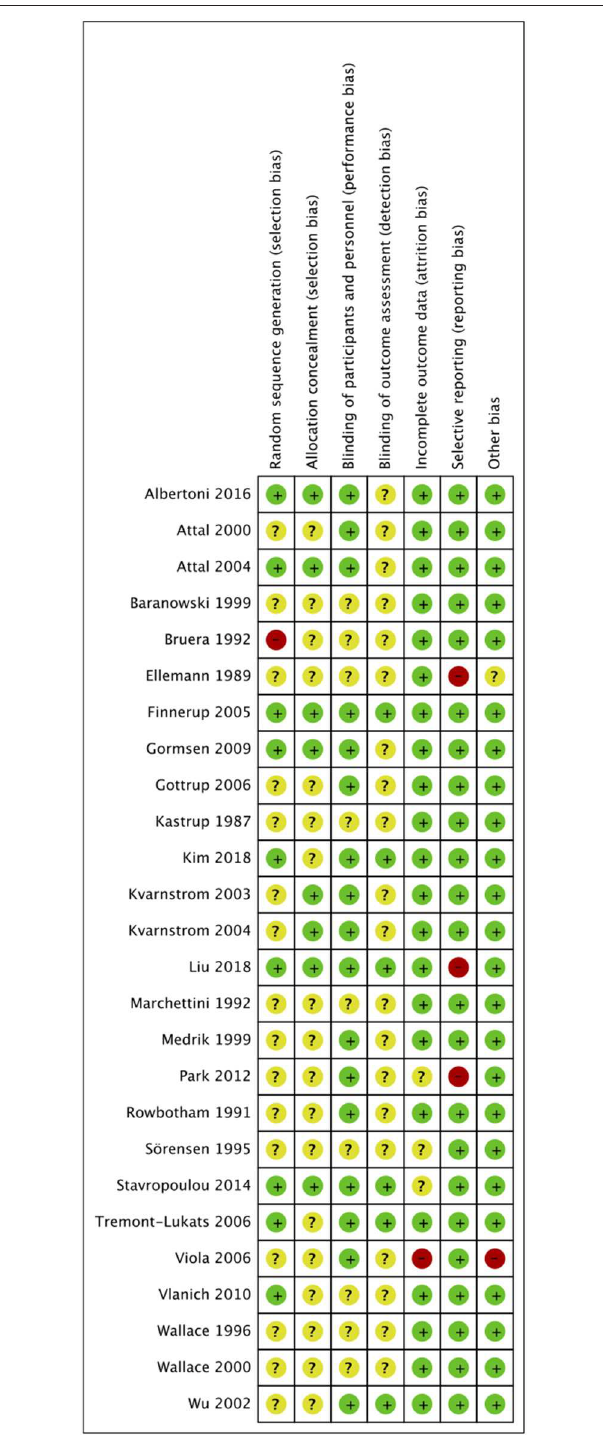
of outcome assessment was clearly mentioned in 6 studies (17, 18, 42, 51, 52, 56). Ten of the studies were categorized as medium quality, while the remaining were rated as high quality